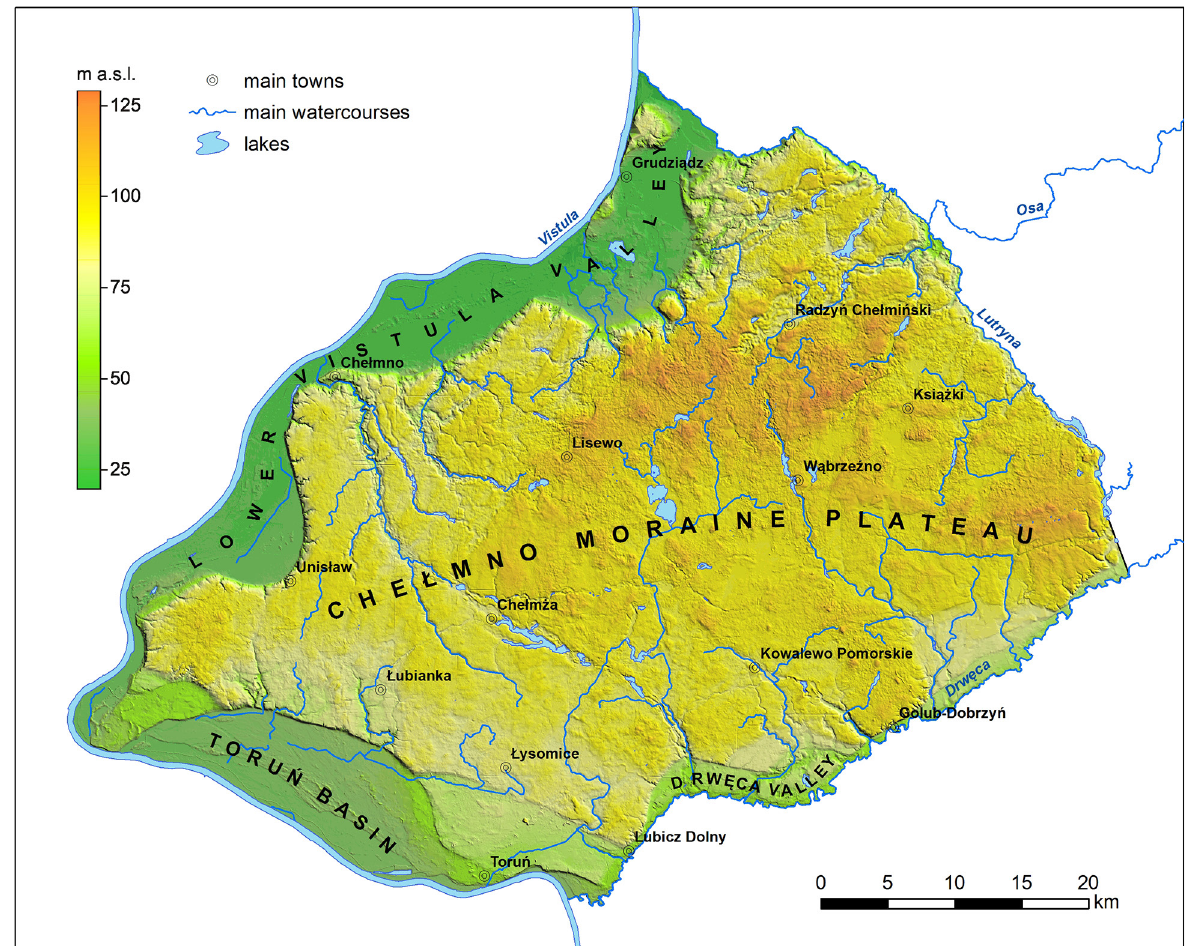
Fig. 2. Physical map of Chełmno